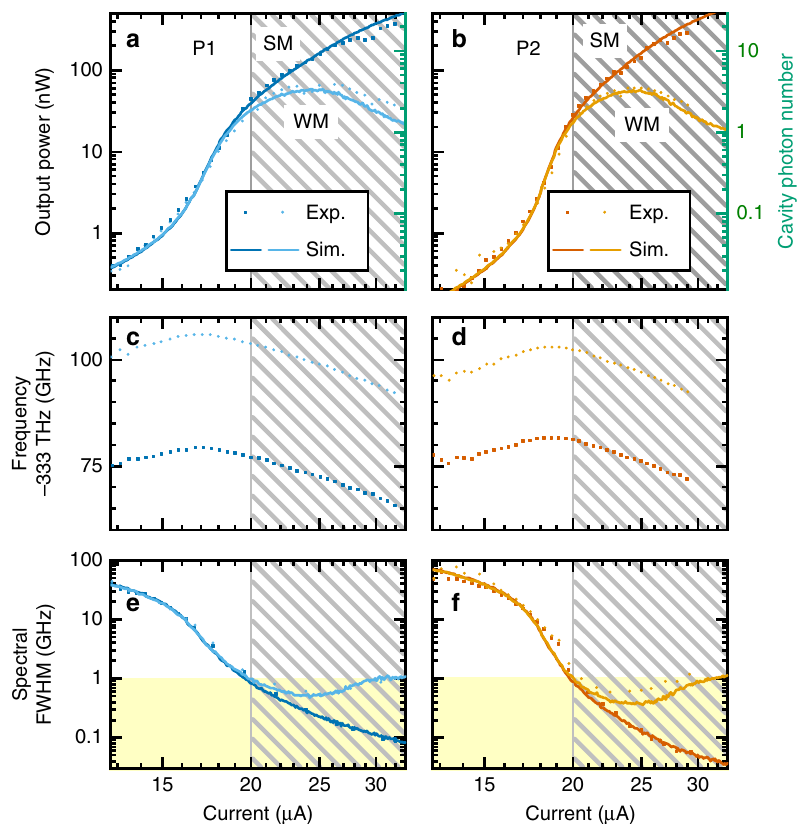
Fig. 2 Input – output characteristics of two QD-micropillar lasers used in mutual coupling experiments. Experimental (dots) and numerical (lines) injection current dependence of output power, emission frequency and linewidth for the strong modes (SM) and weak modes (WM) of pillar P1 (panels a , c , and e ) and pillar P2 (panels b , d , and f ). Dashed areas indicate the operation regime for the mutual coupling experiments which require emission linewidths smaller than one gigahertz (yellow area) and can be achieved for injection currents exceeding 20 μ A. The calculated intracavity photon number presented in panels a and b ranges from about 1 and 20 in the relevant current regime and was determined numerically by our theory